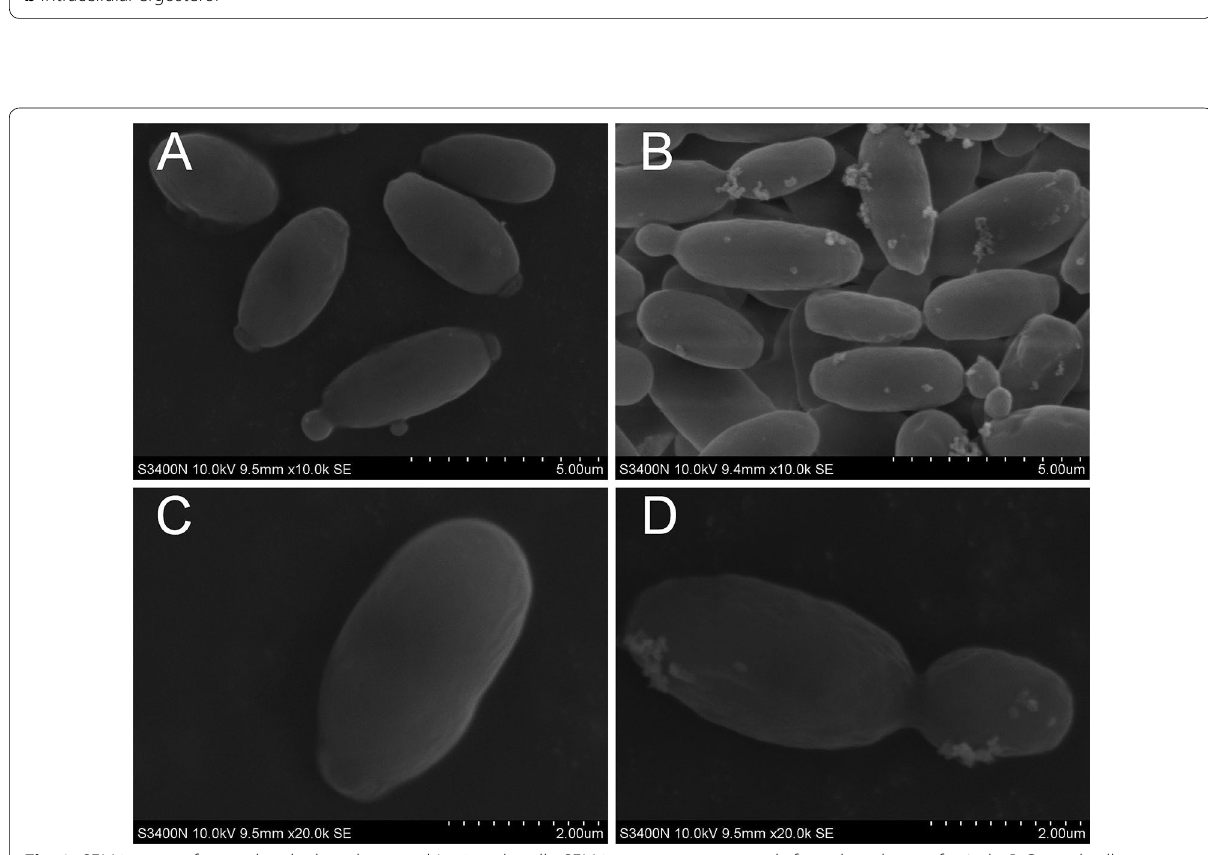
Fig. 2 SEM images of control and ethanol-stressed I. orientalis cells. SEM images were captured after ethanol stress for 24 h. A Control cells at a magnification of 10,000 . B Ethanol-stressed cells at a magnification of 10,000 × cells at a magnification of 20,000